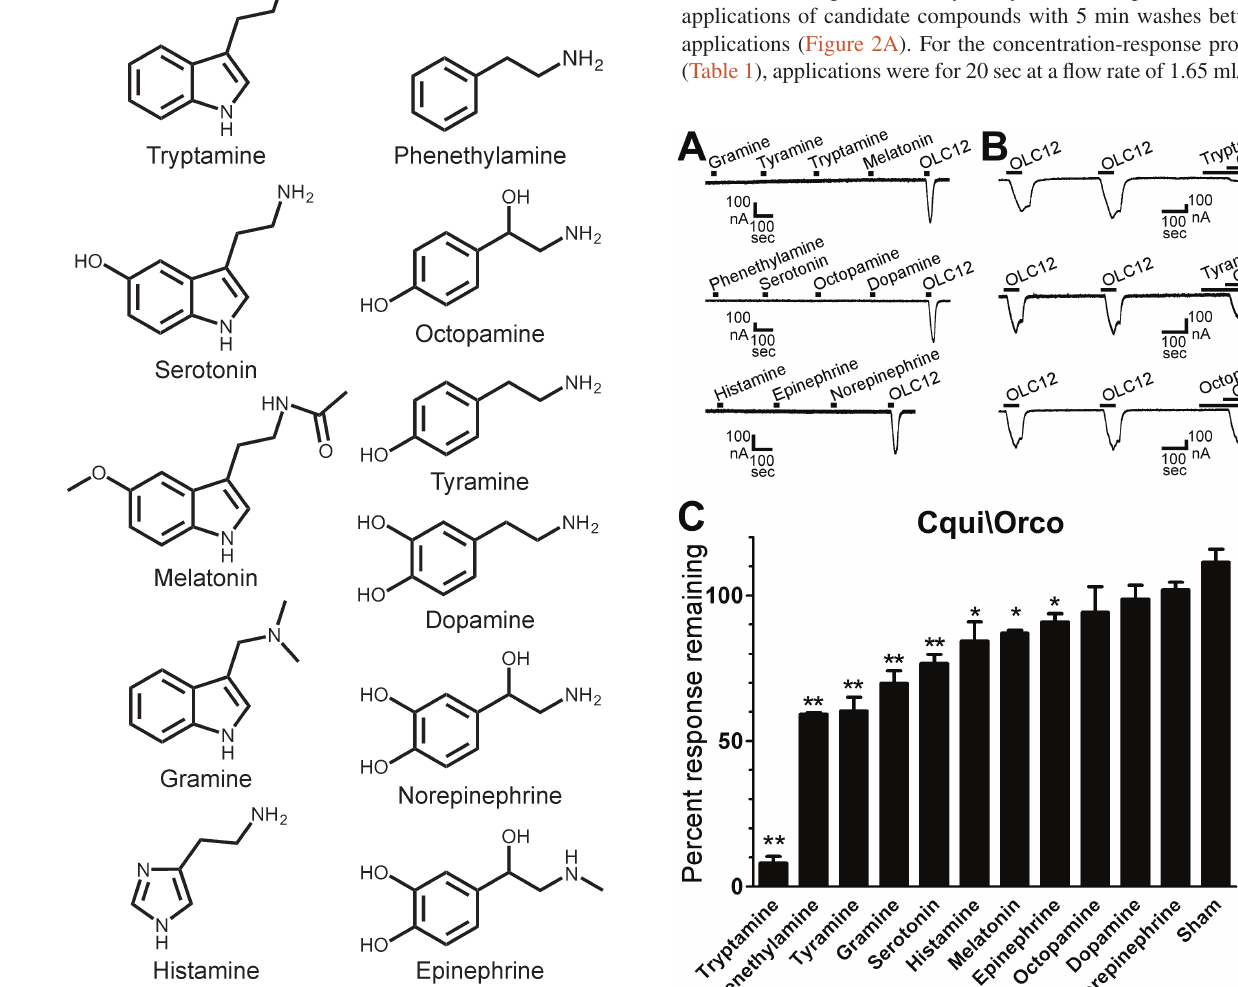
Figure 2. Tryptamine and several other amines are antagonists of Cqui\Orco. A ) The tested amines do not display Orco agonist activity. Oocytes expressing Cqui\Orco were challenged with 30 sec applications of 100µM gramine, tyramine, tryptamine and melatonin (top trace), phenethylamine, serotonin, octopamine and dopamine (middle trace), or histamine, epinephrine and norepinephrine (bottom trace), with 5 min washes between applications. 30µM OLC12 (Orco agonist) was applied at the end of each trace. B ) , 1 2 Tryptamine and tyramine are antagonists of Cqui\Orco. Oocytes expressing Cqui\Orco were exposed to 60 sec applications of 30µM OLC12 with 4 min washes between applications. 100µM tryptamine (top trace), tyramine (middle trace), or octopamine (bottom trace) were applied and incubated for 90 sec preceding the third application of OLC12 and then co-applied during the OLC12 application. C ) Screen of 11 amines for Orco antagonism. Responses of Cqui\Orco to 30µM OLC12 (~EC ) in the presence 5 of 100µM of each compound are presented as a percentage of the average of two preceding responses to OLC12 alone (mean ± SEM, n = 3-10). Statistical significance was assessed by one-way ANOVA, followed by Dunnett’s post-test comparing to sham treated oocytes (*p<0.01;